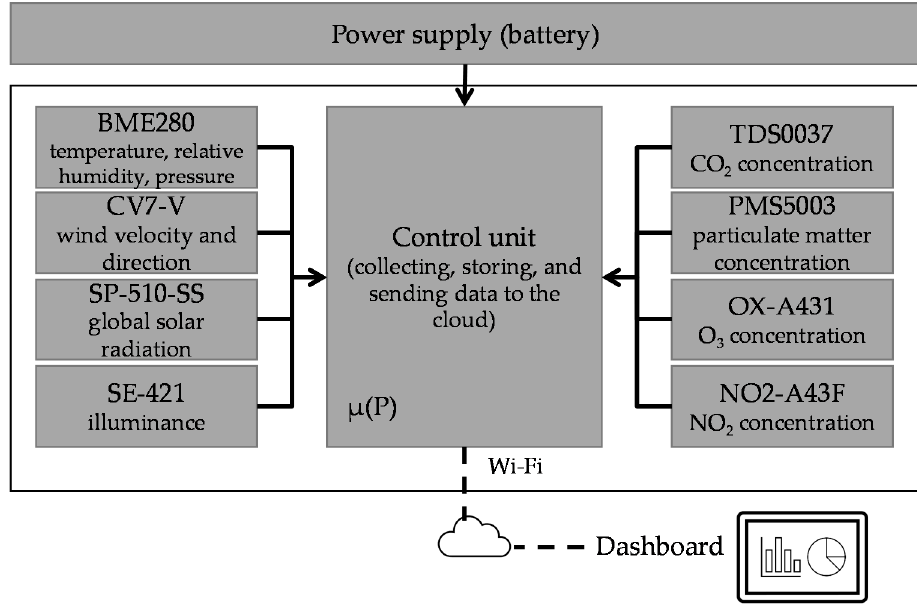
Figure 2. Monitoring system architecture.